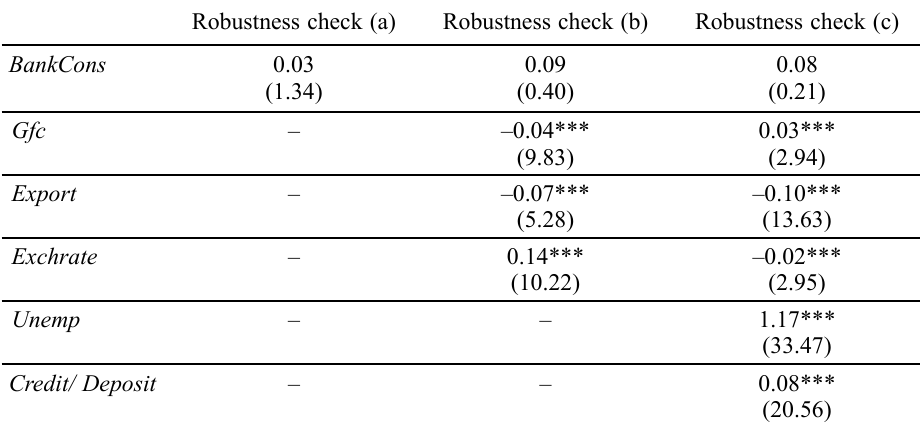
Table 7. Robustness check of panel FMOLS